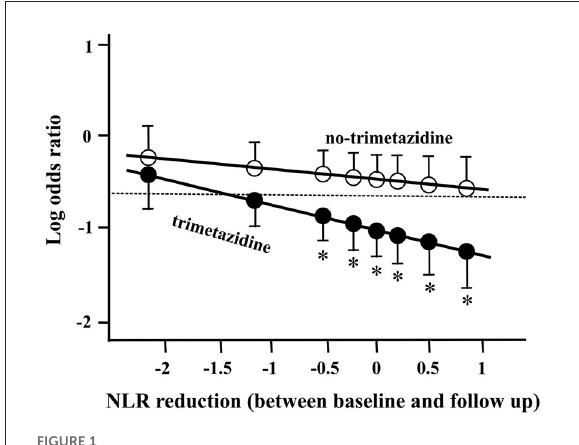
FIGURE1 In-stent restenosis (ISR) log odds ratios and 95% confidence intervals in relation to the reduction of neutrophil lymphocyte ratio (NLR) between baseline and follow-up, defined by trimetazidine (TMZ) therapy. The dotted line represents the average ISR log odds of all patients (33.84%) in this statistical model. Asterisk ( * ) indicates significant difference ( p < 0.05) between the groups (TMZ and